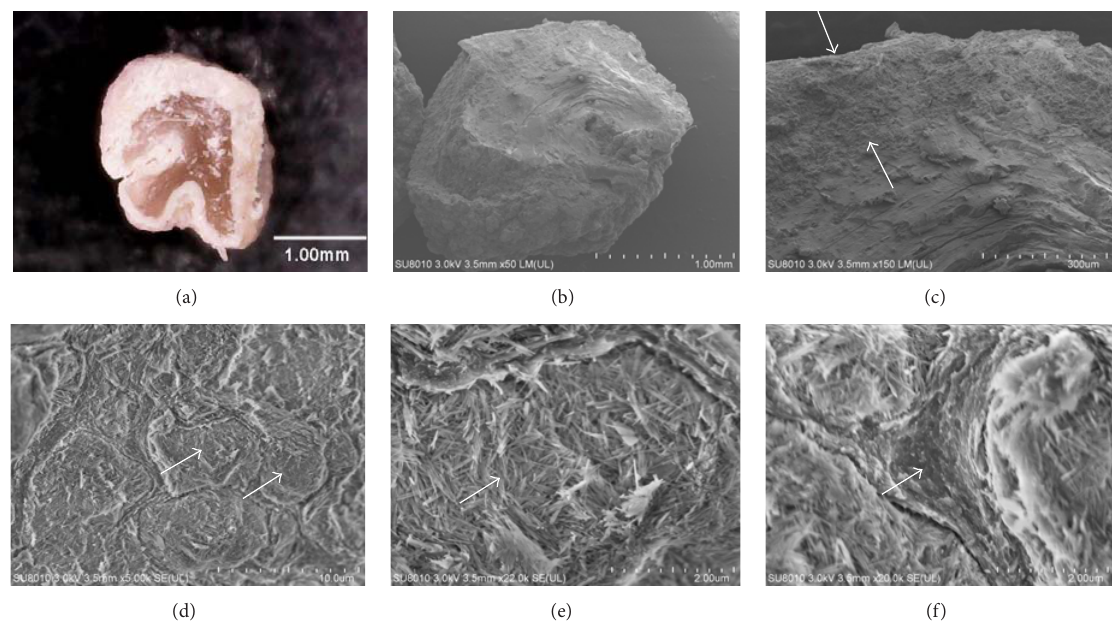
Figure 2: The morphology of the cellulose-attapulgite composite particles (AC2) ((a) cross section of particle by digital microscope; (b) cross section of particle by SEM; (c) shell structure of particle; (d) aggregation area of attapulgite; (e) amplified aggregation area of attapulgite; (f) area of sodium alginate).